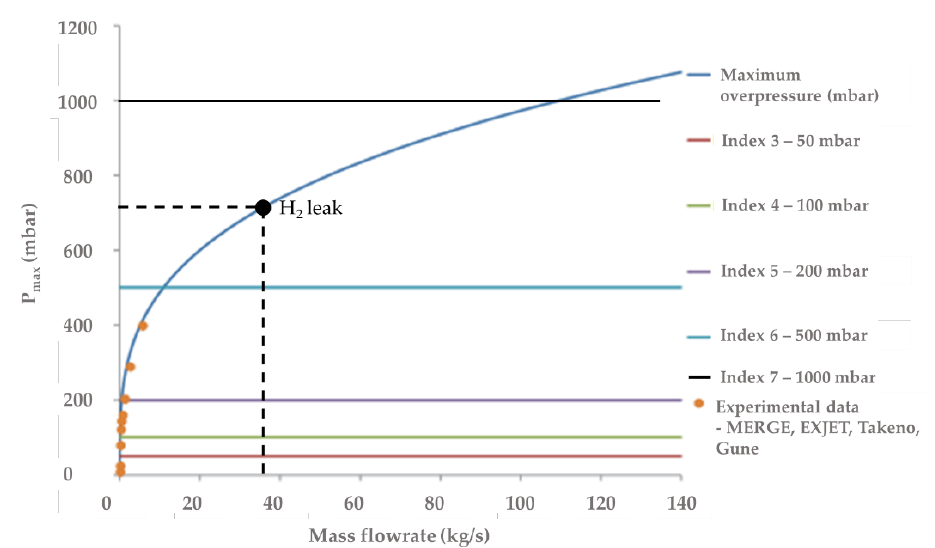
Figure 6. Explosion overpressure as a function of the mass flow rate of the hydrogen jet at the EZ53 salt cavern [29].